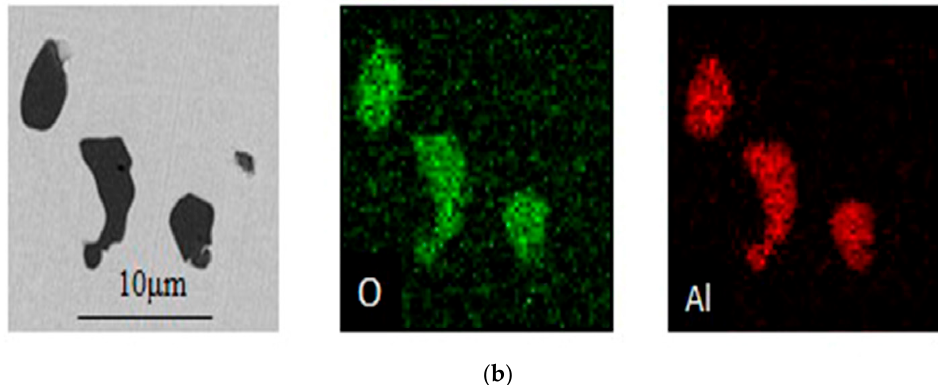
Figure 2. EDS (Energy Dispersive Spectroscopy) results of the typical Al 2 O 3 inclusion from sample. ( a ) Point scan analysis; and ( b ) elemental distribution in Al 2 O 3 inclusion.